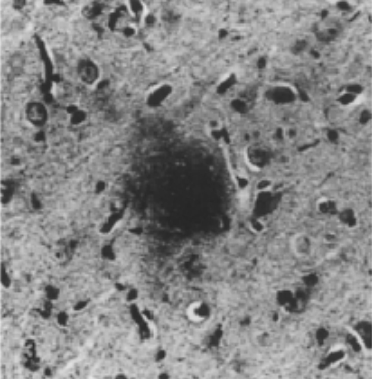
Figure 9. A diffuse plaque in the cerebral cortex of a camel. Periodic acid methenamine silver (PAM), ×225. Reprinted by permission from Springer Nature , Acta Neuropathologica, senile plaques in an aged two-humped (Bactrian) camel ( Camelus bactrianus ). Nakamura S., Nakayama H., Uetsuka